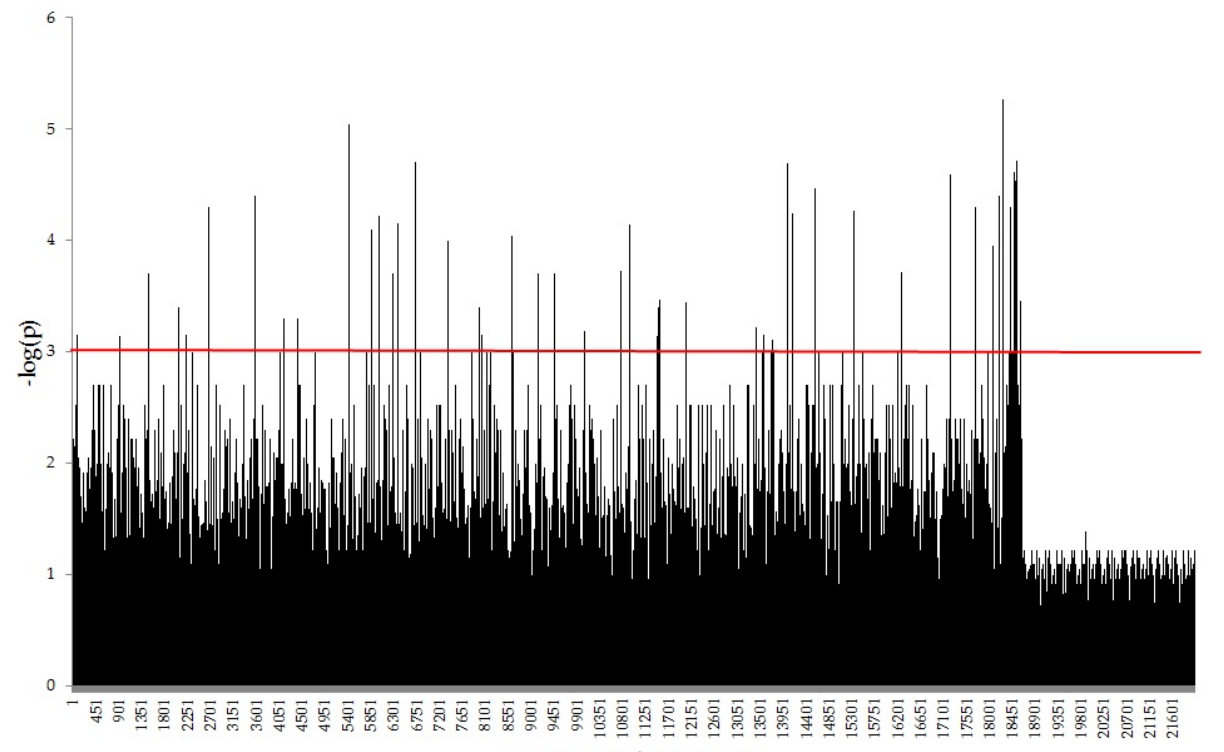
Figure 2. Manhattan plots for seed germination.